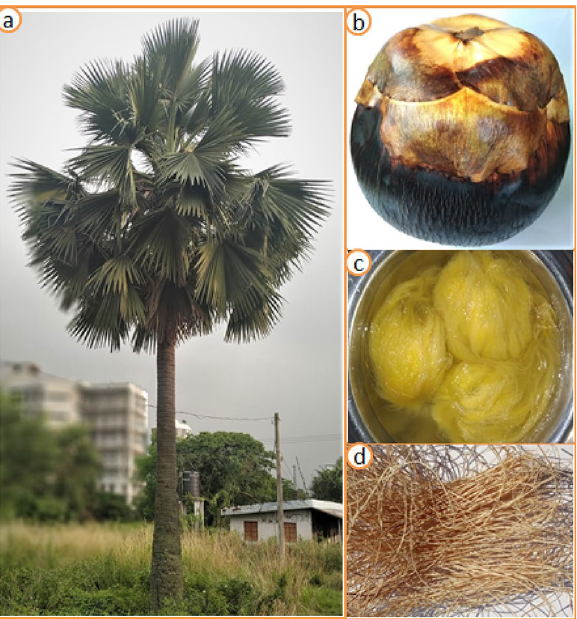
Figure 1. Corypha taliera fruit fiber extraction: ( a ) Corypha taliera plant; ( b ) Corypha taliera fruit; ( c ) Fruit seeds immersed into water; ( d ) Extracted dry